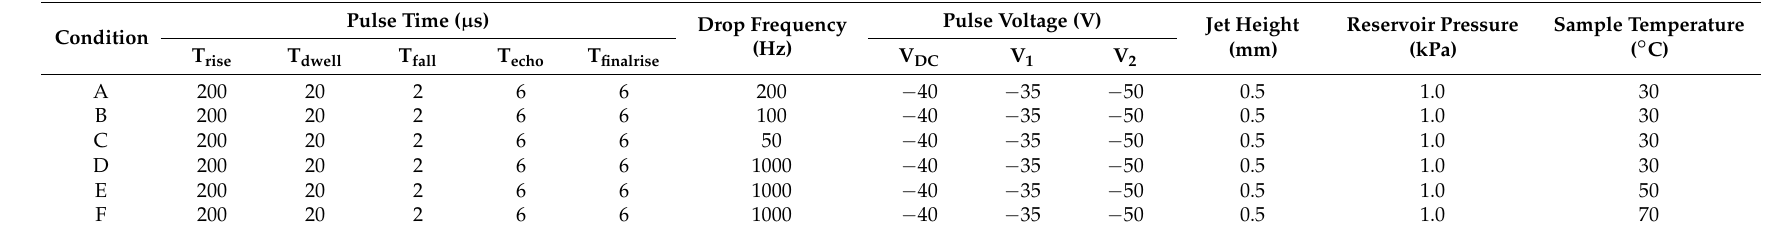
Table 2. The experimental conditions of the inkjet